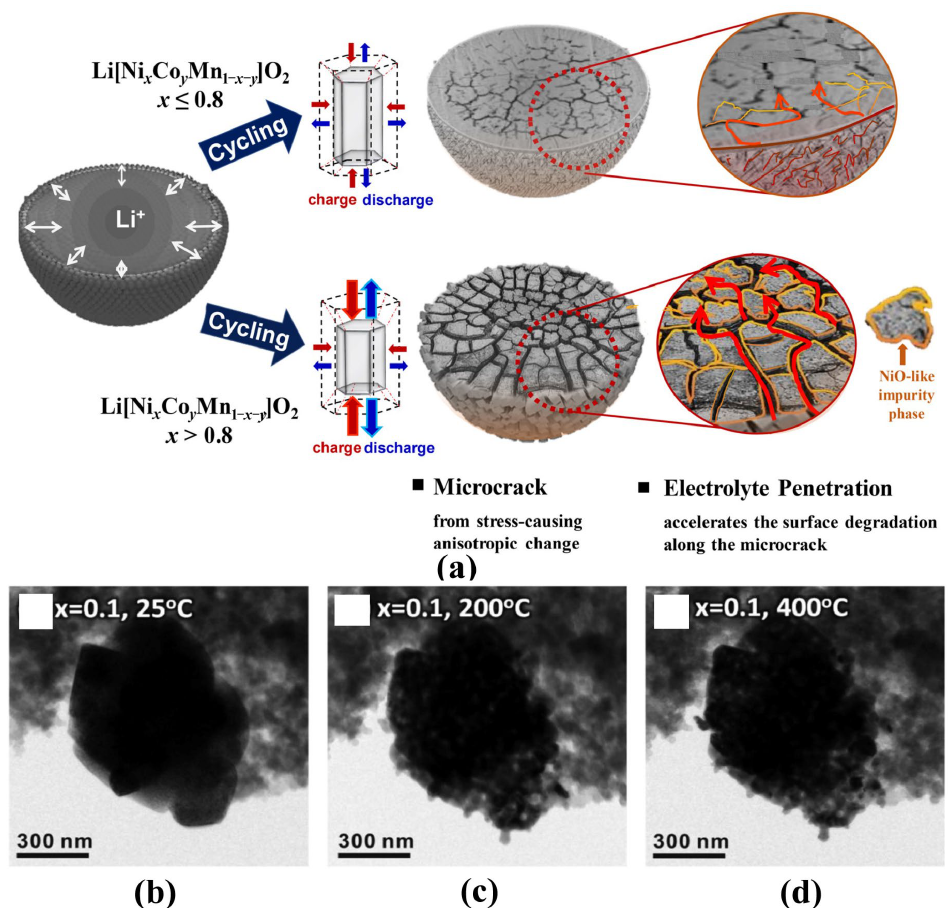
Figure 3. ( a ) Scheme of microcrack generation and electrolyte penetration [37]. In situ TEM images ( b ) before heating (25 °C), after heating at ( c ) 200 °C, and ( d ) 400 °C for a Li 0.1 Ni 0.8 Co 0.15 Al 0.05 O 2 particle [36].